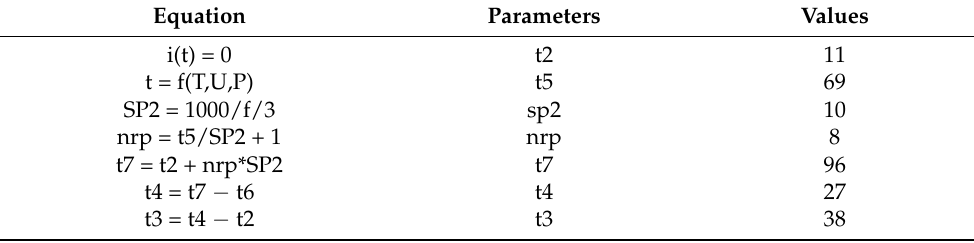
Table 11. The equation used in simulation of connection process of the circuit